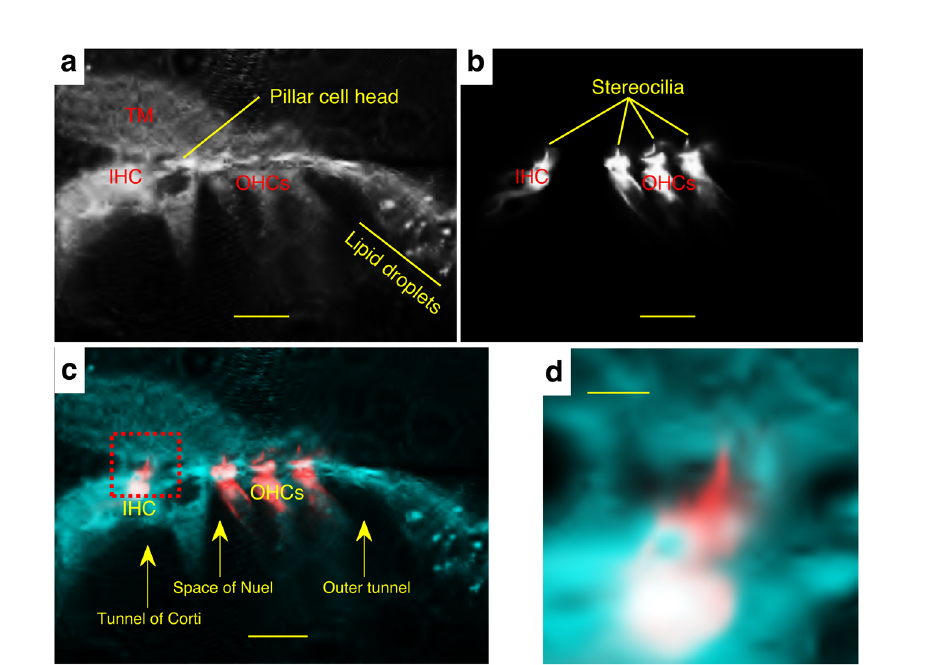
Fig. 2 IHC and OHC stereocilia bundles alike are TM-embedded. a Re fl ected light confocal image of the OC showing tight interaction between the TM and RL. b Fluorescence confocal image of the same focal plane as in a after staining the OC with the membrane dye di-3-aneppdhq. c Overlay of images from a and b revealed that stereocilia of IHCs are TM-embedded in a similar fashion as the OHC stereocilia. d A closeup view on the IHC region (see red square in c ) highlights the IHC stereocilia embedment within the TM. Scalebars: 25 µ m in a , b , and c ; 5 µ m in d . Data in a – d were representative of ten different